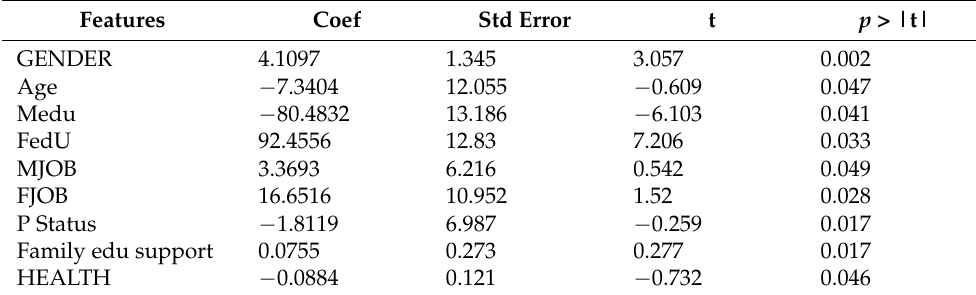
Table 6. Final OLS